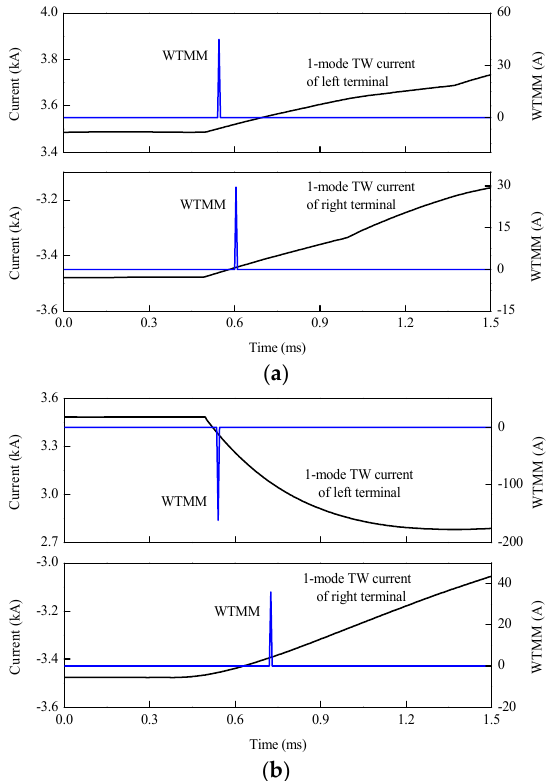
Figure 16. WTMMs of 1-mode TW current for different fault sections: ( a ) wavelet transform modulus maxima (WTMM) for internal fault; ( b ) WTMM for external fault.